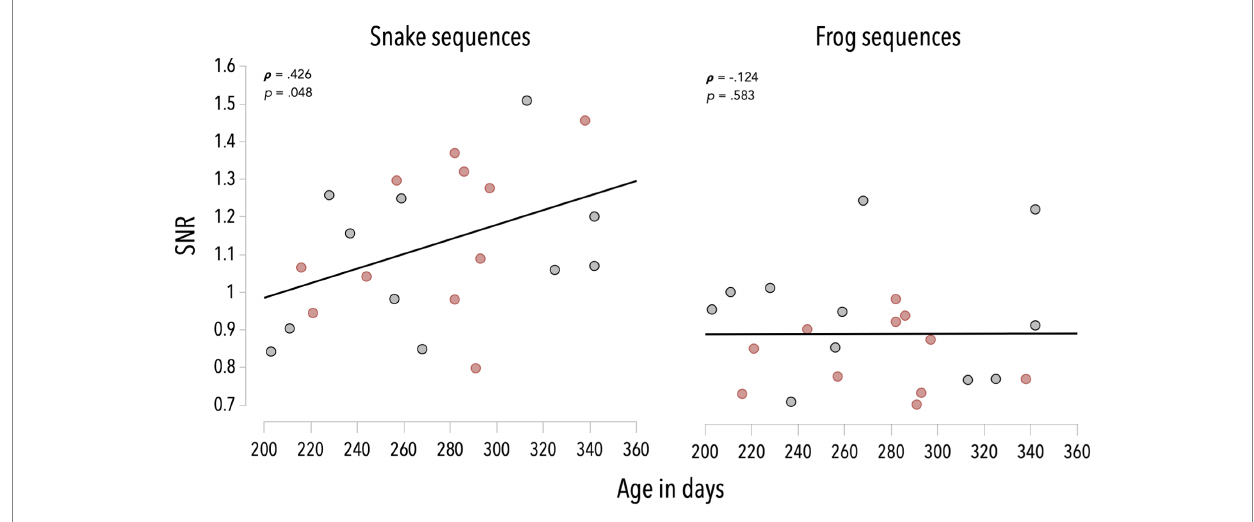
FIGURE 3 Associations between infants’ age and SNR values averaged on the first six harmonics of the category-selective response, for snake and frog sequences. Red dots refer to infants in the color group, grey dots refer to infants in the grayscale